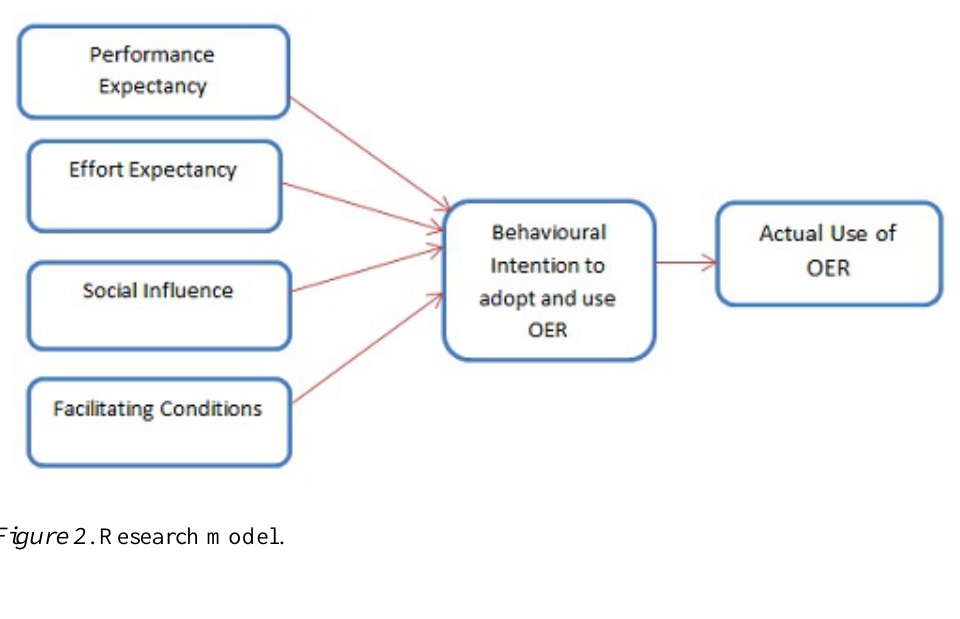
Figure 2 . Research